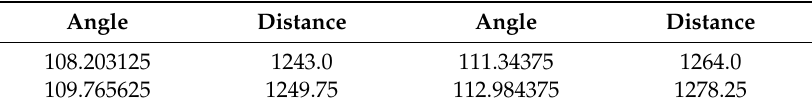
Table 1. Sample angle and distance data obtained from RPLidar A2 lidar sensor.